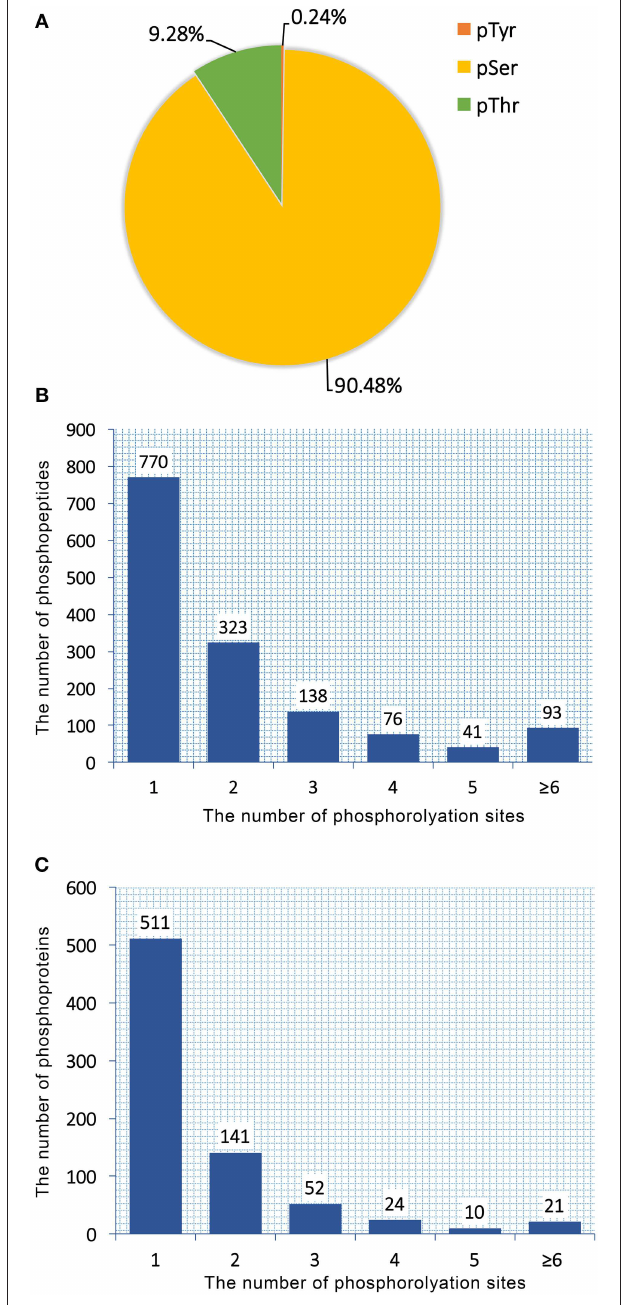
FIGURE 1 | Overall characteristics of the phosphoproteome of RH, PRU and PYS strains of Toxoplasma gondii . Distribution of phosphorylated residues and phosphorylation sites per peptide. (A) Distribution of phosphorylation on serine (pSer), threonine (pThr), and tyrosine (pTyr) for all phosphorylation sites. (B) Number of identified singly and multiply phosphopeptides. The majority of phosphopeptides have only one phosphorylation site. (C) Distribution of 759 phosphoproteins based on identification of single or multiple phosphosites per protein. The number of proteins with multiple phosphosites decreases with increasing the number of